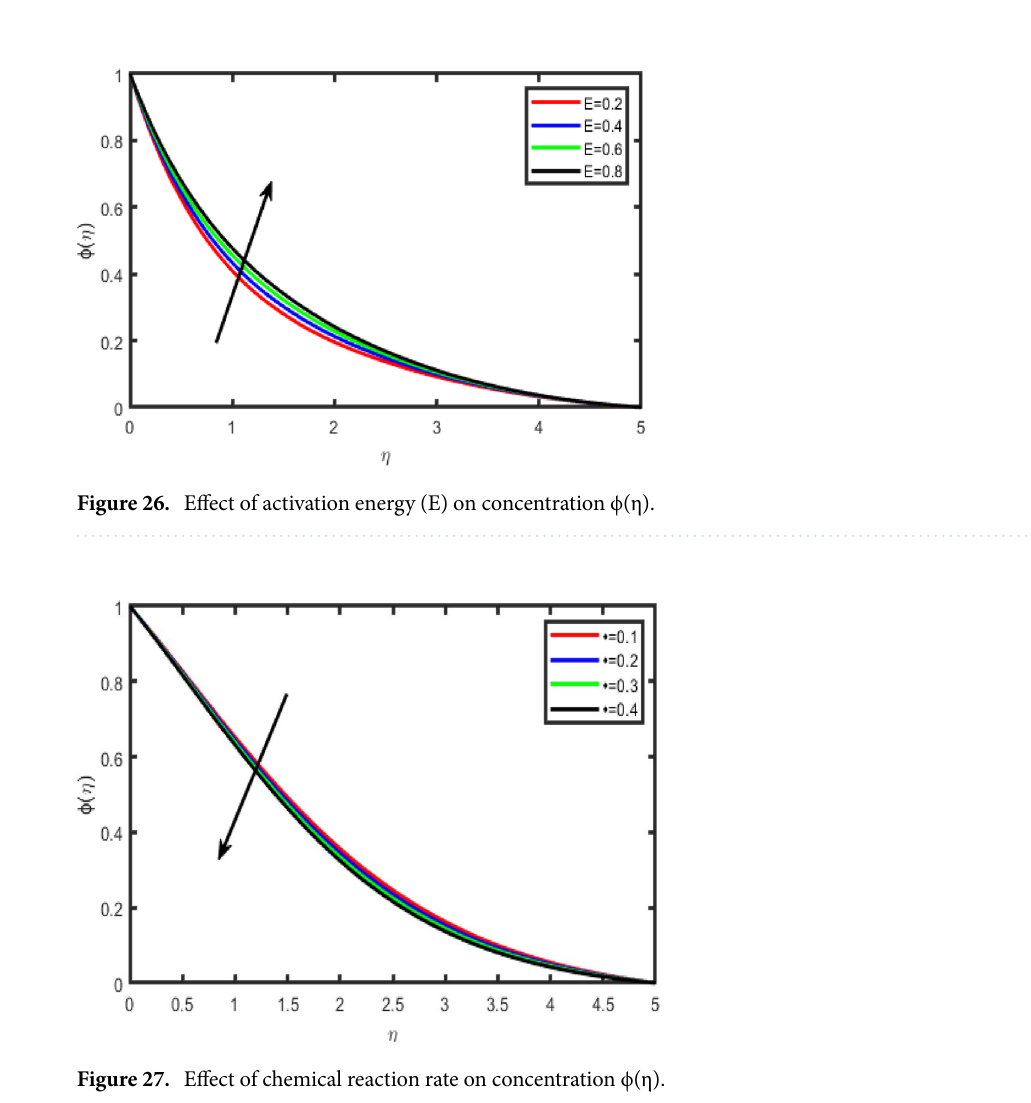
Figure 25. Effect of Lewis number (Le) on concentration ϕ(η).